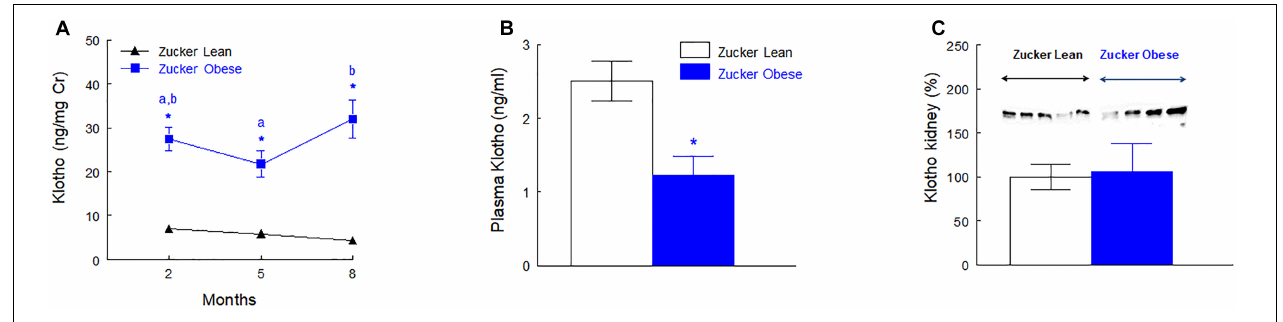
FIGURE 3 | Urinary excretion of Klotho normalized by creatinine excretion (A) , plasma levels of Klotho (B) at the end of the experiment (8 months old) and renal protein abundance of Klotho (C) in male Zucker lean and obese rats. Data are means ± SEM. ∗ p < 0.05 compared with Zucker lean rats ( n = 10, each group). Means with the same letter (a or b) indicates sets of means within there are no significant difference at p < 0.05.